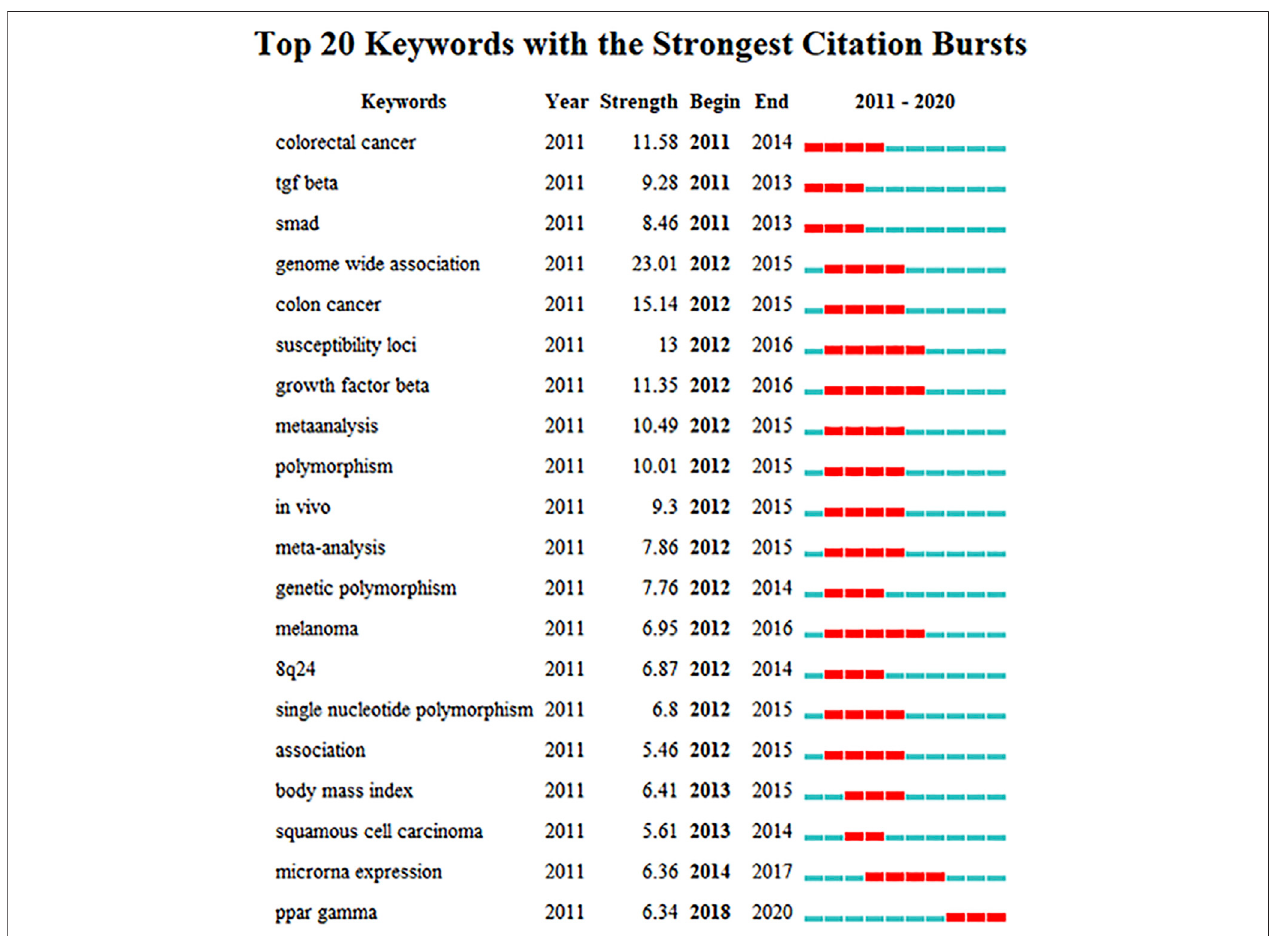
FIGURE7| Top20keywordswiththestrongestcitationbursts.Footnote:Thestrongestcitationburstmeansthatavariablechangesgreatlyinashortperiod.Red bars indicate the duration of the burst.